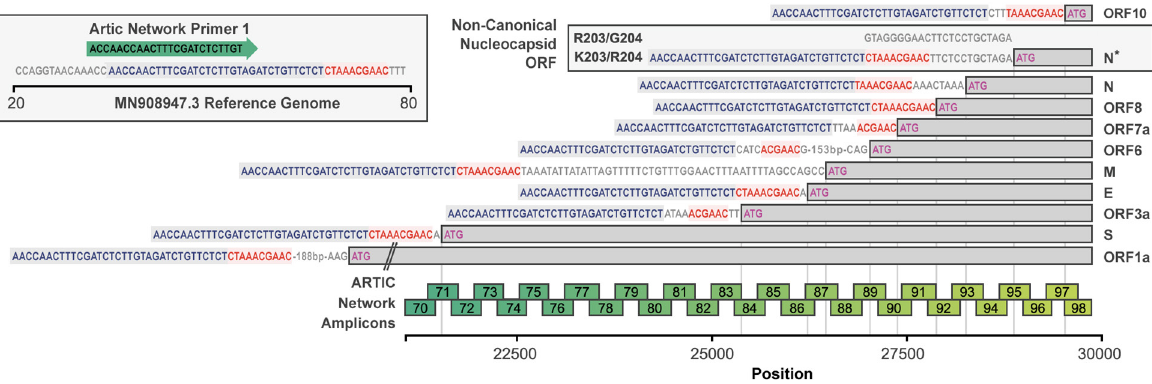
Figure 3. The configuration of canonical sgRNAs and the novel non-canonical nucleocapsid sgRNA (N*) in SARS-CoV-2. The bottom bar illustrates the presence of the leader sequence (blue text) followed by the transcription-regulating sequence (TRS; red text) within the genomic sequence that continues into the first ORF 1a. The presence of other canonical sgRNA transcripts in which the leader sequence and TRS precede the start codon (methionine; pink) of the other proteins are shown. The presence of the novel non-canonical sgRNA transcript containing the K203/R204 polymorphisms (N*) is shown. The ARTIC primer locations and resultant amplicons are